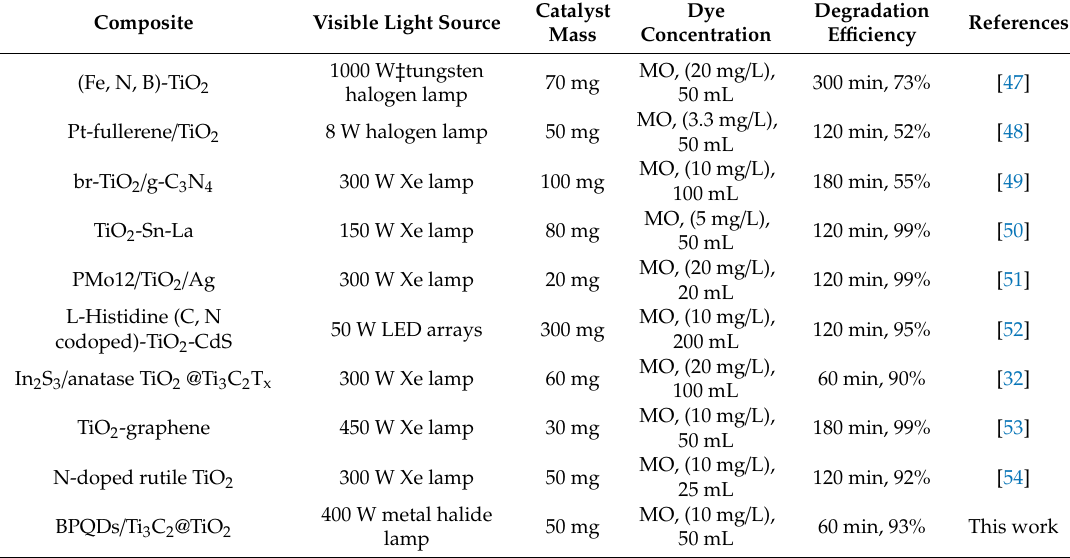
Table 1. Di ff erent TiO 2 -based composites for photocatalytic degradation of MO under visible light